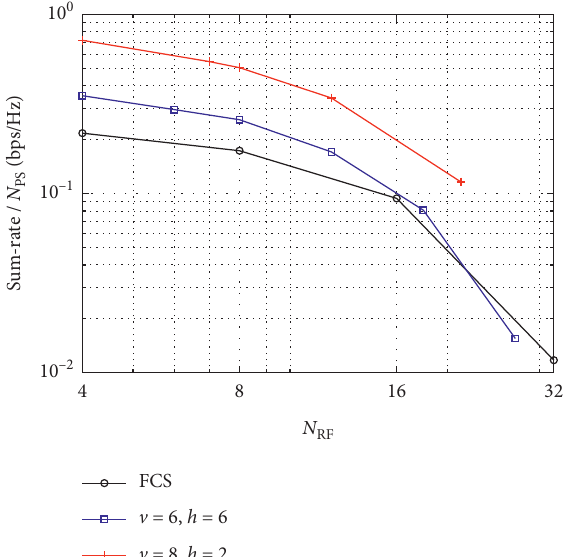
Figure 8: Sum-rate per phase shifter versus the number of RF chains.